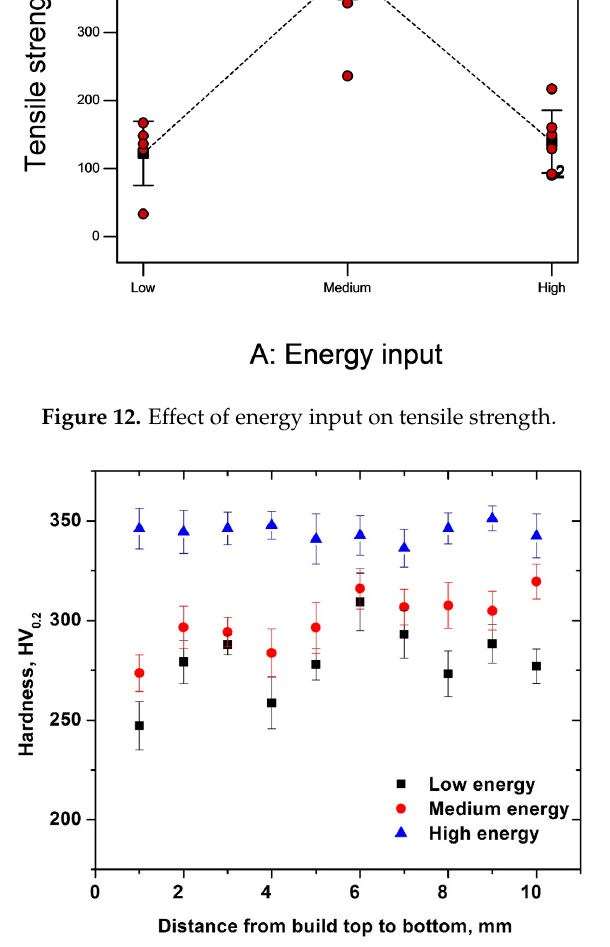
Figure 13. Microhardness distribution from the top to bottom portion of cubes.